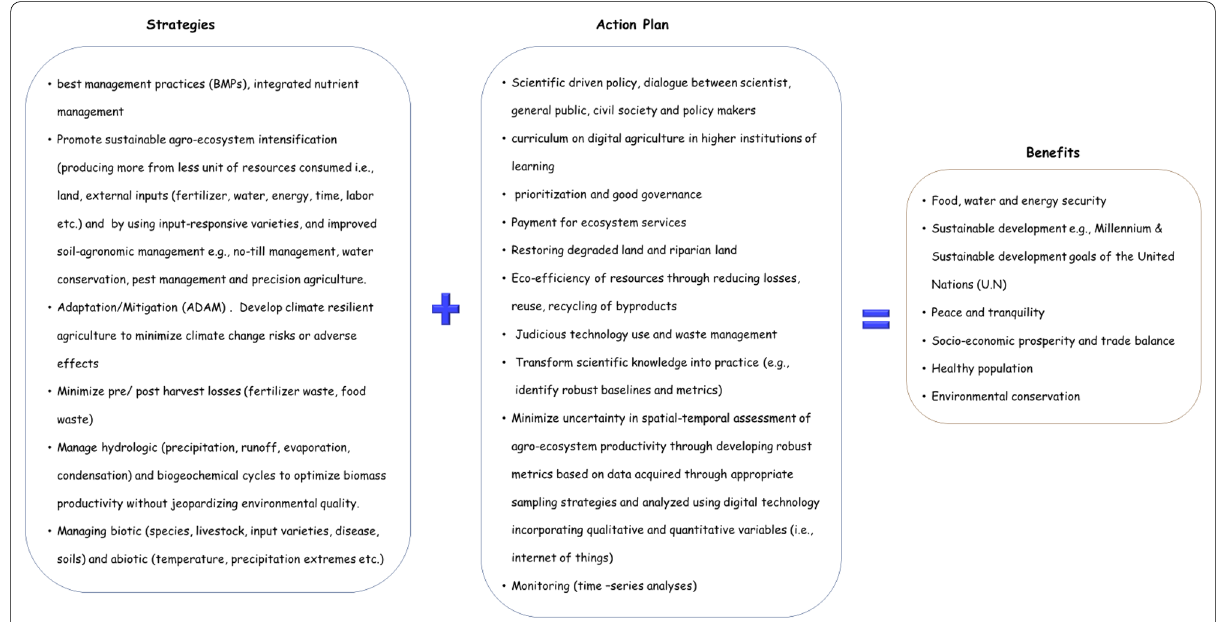
Fig. 2 A schematic illustration of the opportunities implementable by digital agriculture technologies (Modified from Lal (2013), de Paul Obade and Lal